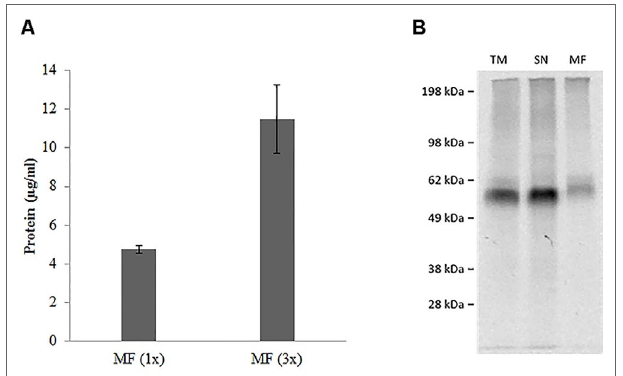
FIGURE 3 | (A) Repetitive batch expression of NC-hSERT in S ƒ21 system. Protein yields in µg/mL determined by incorporation of [14C] leucine; samples were fractionated, the microsomal fraction (MF) was quantified; different bar colors represent different potassium concentrations in the TT mix; bars show mean protein yield of duplicate measurements with error bars showing the SD. (B) Autoradiography for batch based Expression of NC-hSERT in the Sƒ 21 system. Samples were fractionated into translation mix (TM), supernatant 1 (SN) and microsomal fraction